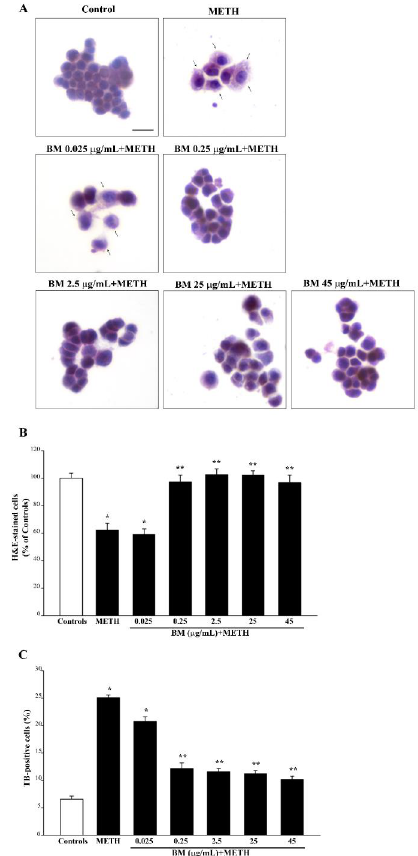
Figure 3. BM reduces toxicity induced by METH. ( A ) Representative H&E pictures showing marked morphological changes induced by METH (100 µ M) compared with control, consisting of increased eosin staining of the cytosol and altered morphology (arrows). These alterations are reduced dose- dependently by pre-treatment with various doses of BM. Assessment of PC12 cell viability through ( B ) H&E staining, and ( C ) TB staining following exposure to METH (100 µ M) alone or in combination with increasing BM doses (from 0.025 µ g/mL up to 45 µ g/mL). Values are given as the mean percentage ± S.E.M. of cells from three independent experiments. * p < 0.05 compared with controls; ** p < 0.05 compared with METH. Scale bar = 12 µ